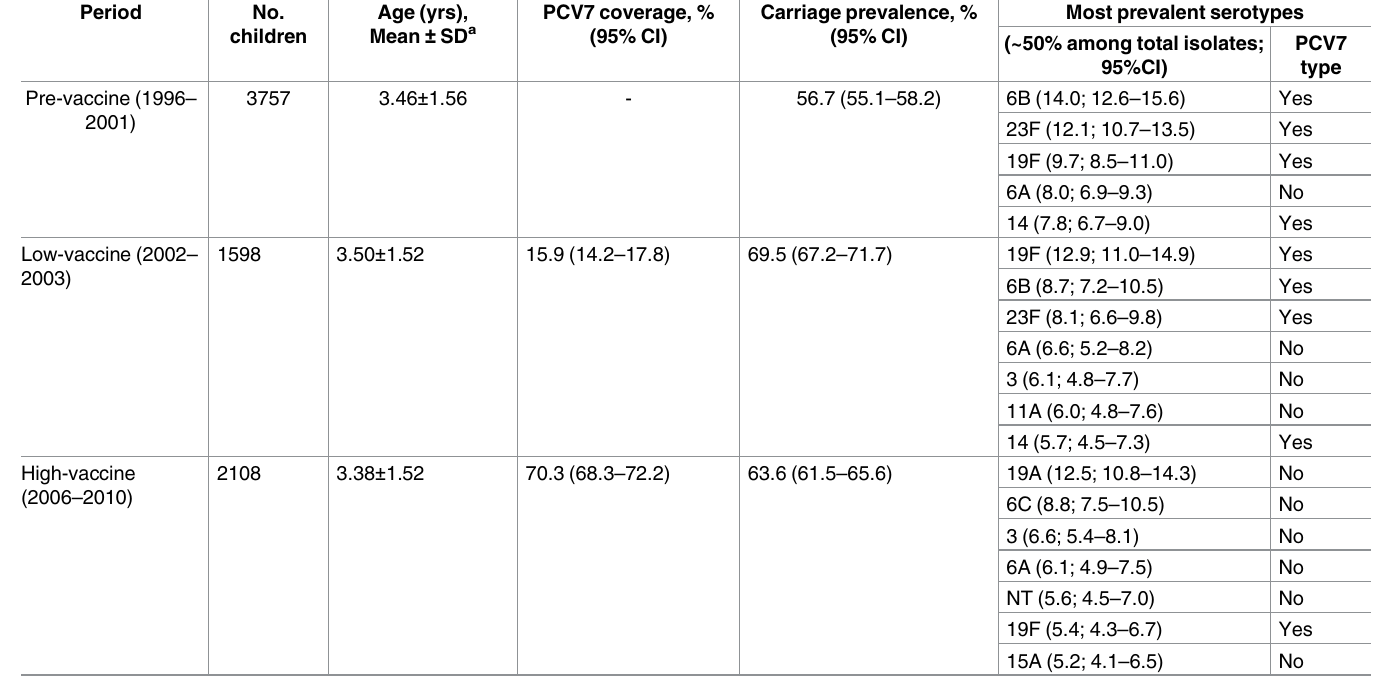
Table 1. Characteristics of the population under study stratified by PCV7 coverage.